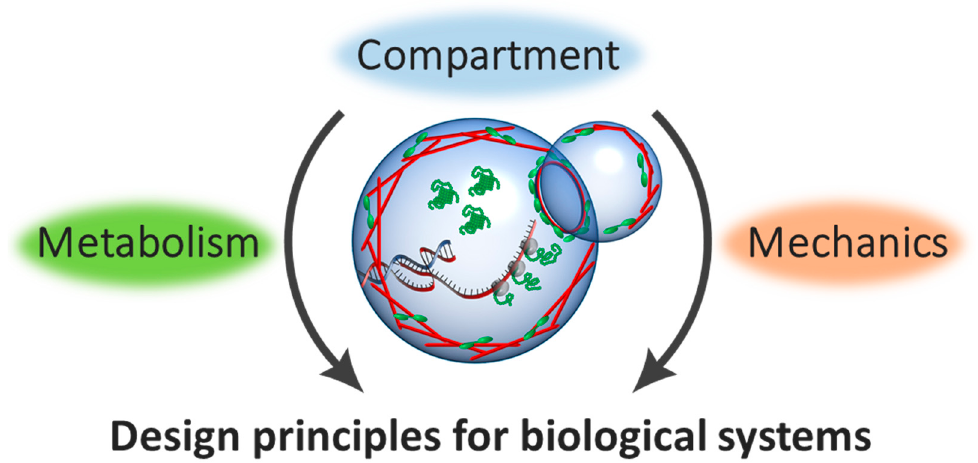
Figure 1. Basic components of the cell. The cell-sized compartment is comprising of cytoskeleton beneath the membrane (red rods, green motor-proteins), metabolism for molecules (green) synthesized by gene expression from DNA (red and blue double helix).